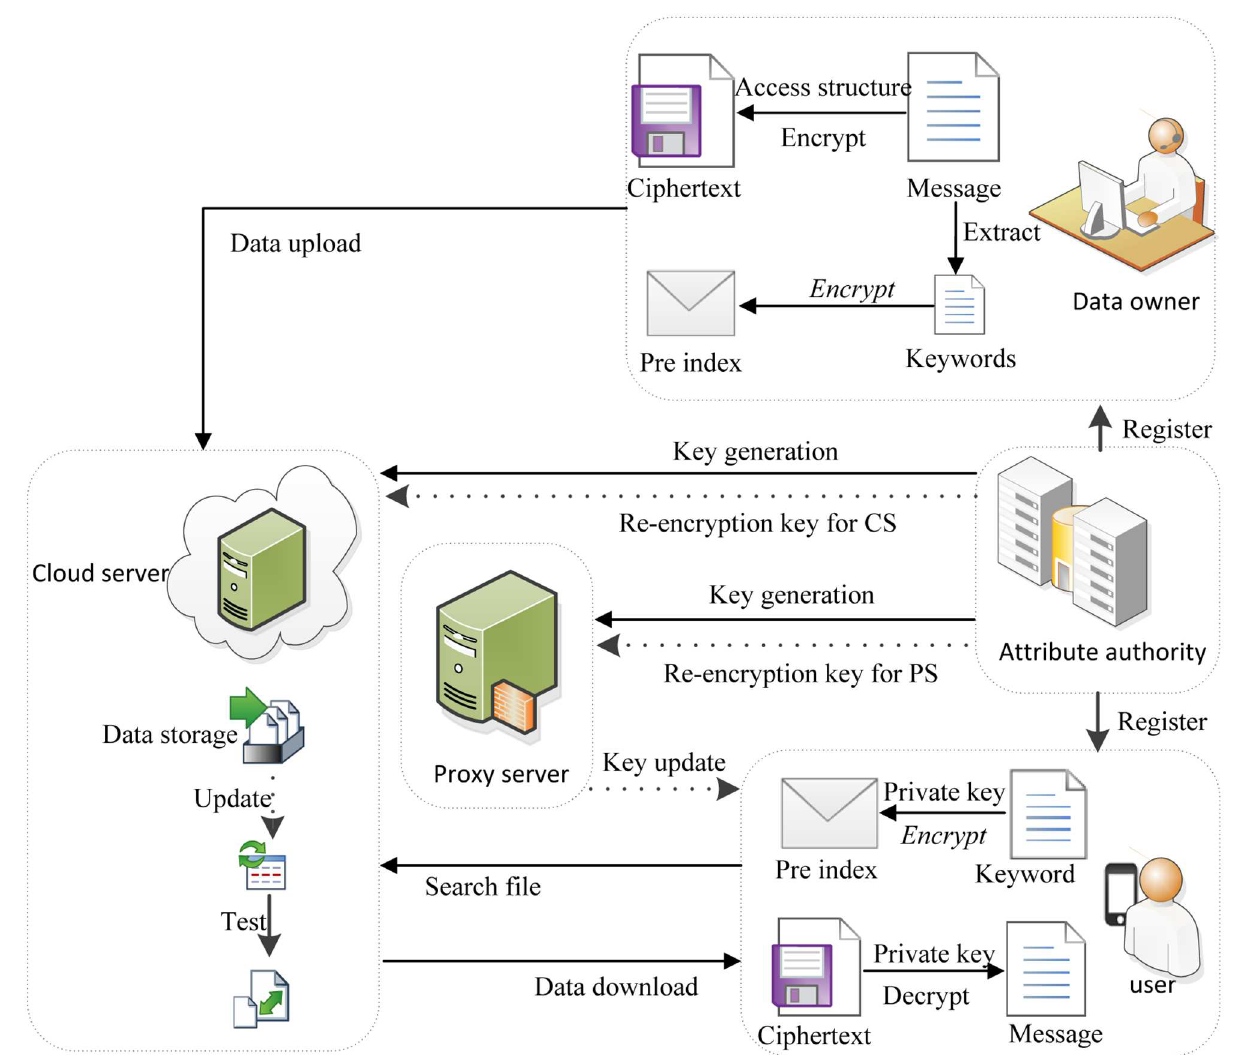
Fig 1. System model of the proposed